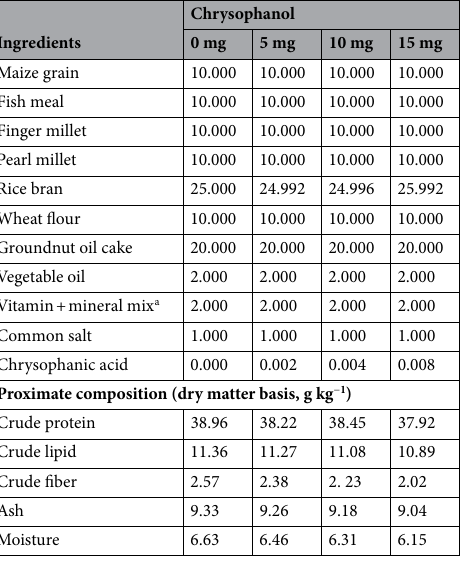
Table 1. Ingredients on dry matter basis and proximate composition experimental feed used in this study. a Vitamin and minerals pre mix: Vitamin A: 700,000 IU, Vitamin D3: 140,000 IU, Vitamin E: 500 mg, Vitamin B12: 1000 mcg, Folic acid: 100 mg, Nicotinamide: 1000 mg, Copper: 1200 mg, Cobalt: 150 mg, Iron: 1500 mg, Zinc: 3000 mg, Iodine: 325 mg, Selenium: 10 mg, Magnesium: 6000 mg, Manganese: 1500 mg, Potassium: 100 mg, Calcium: 27 mg, Phosphorus: 13 mg, Sulphur: 0.72 mg, Fluorine: 300